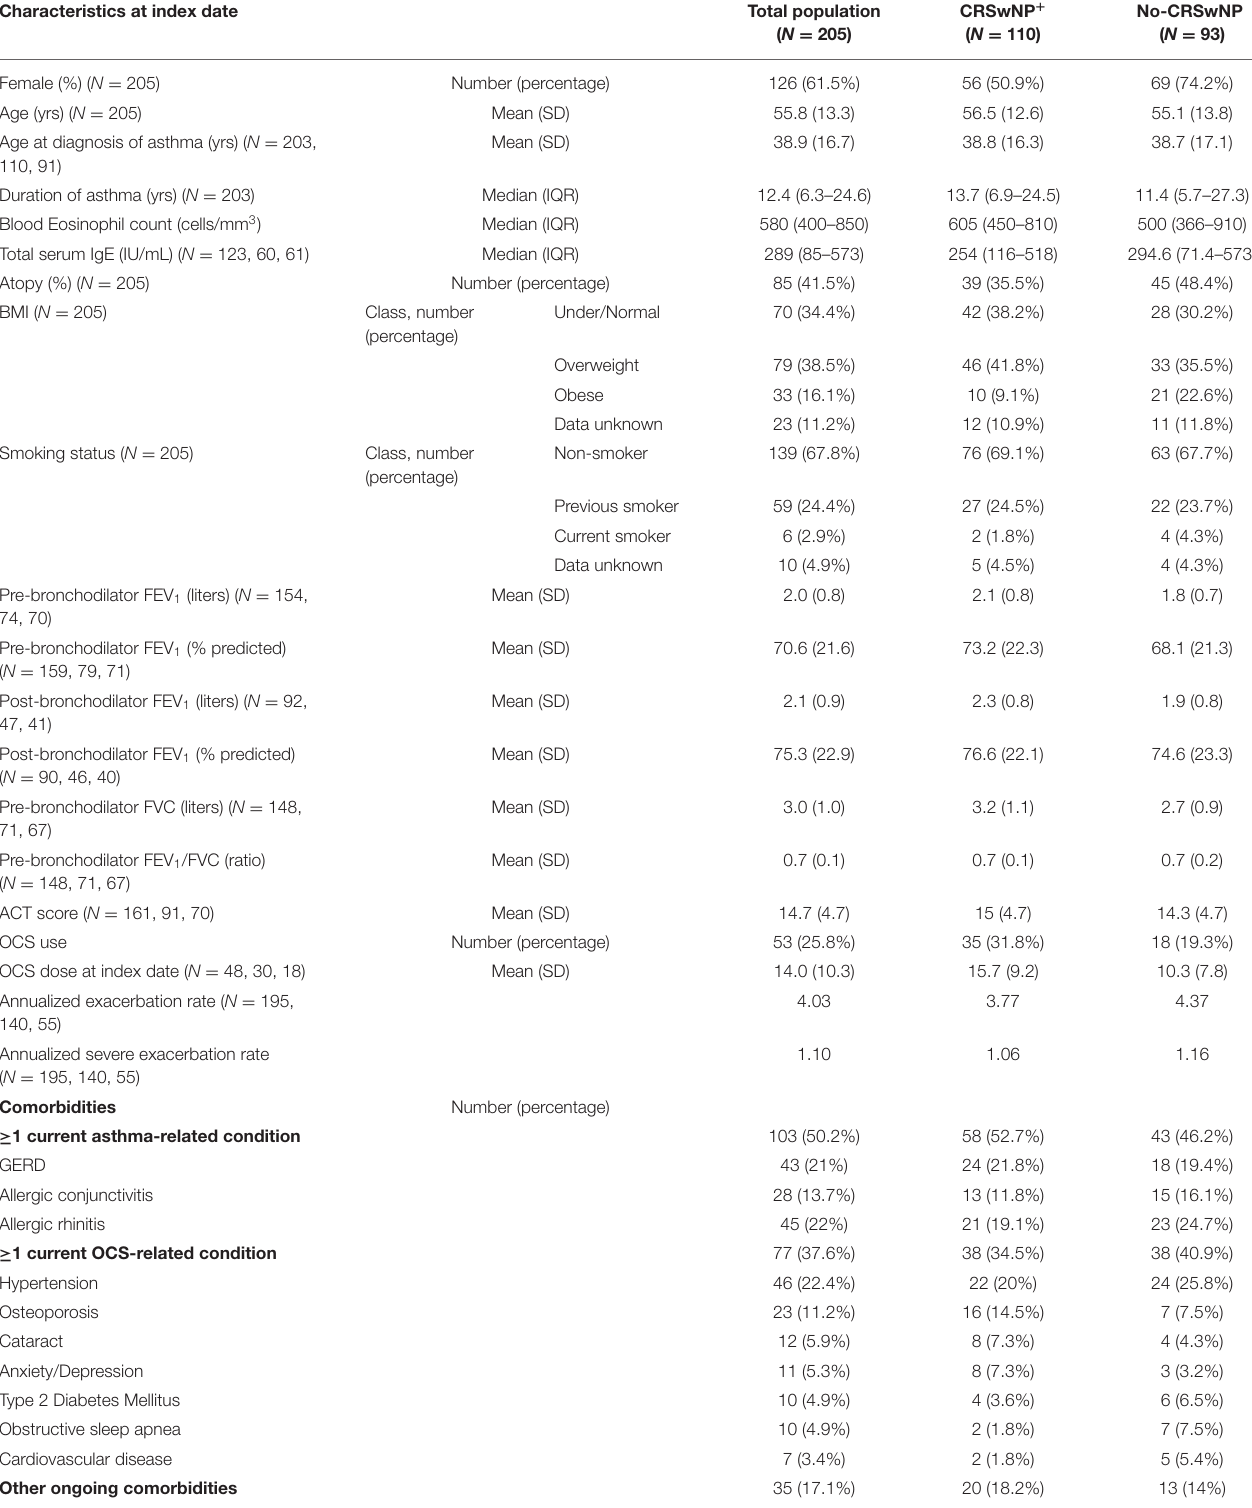
TABLE 1 | Demographic, clinical, and laboratory features of the patient